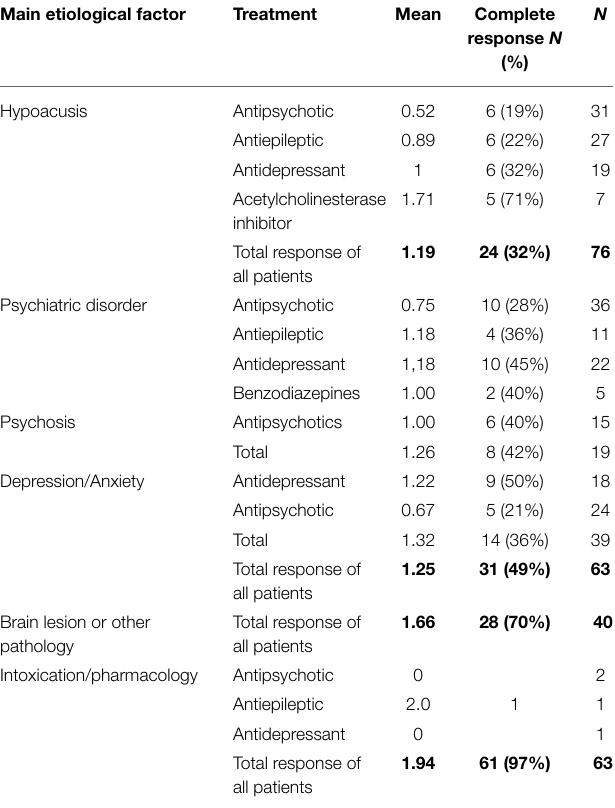
TABLE 3 | Mean effect of (pharmacological) treatment on musical hallucinations (0 = no effect, 1 = clinically meaningful, 2 = complete